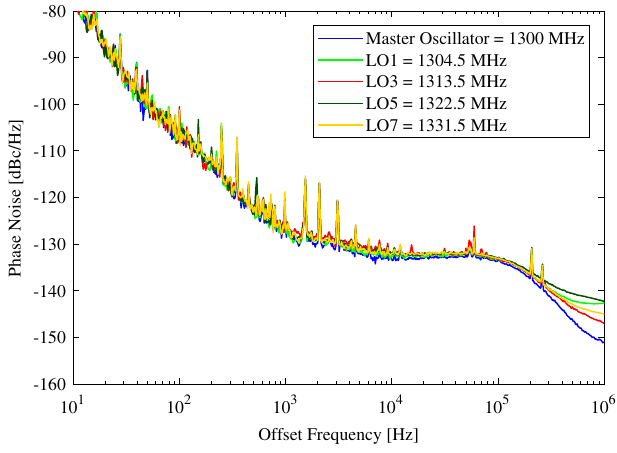
FIG. 8. MO and LO phase noise versus offset frequency. The rms jitter for each oscillator within the interval of offset frequency ð MO Þ ¼ 56 fs, from 10 Hz to 1 MHz is as follows: Δ T rms Δ T ð LO 1 Þ ¼ 57 fs, Δ T ð LO 3 Þ ¼ 57 fs, Δ T ð LO 5 Þ ¼ rms rms rms 57 fs, and Δ T ð LO 7 Þ ¼ 58 fs. rms